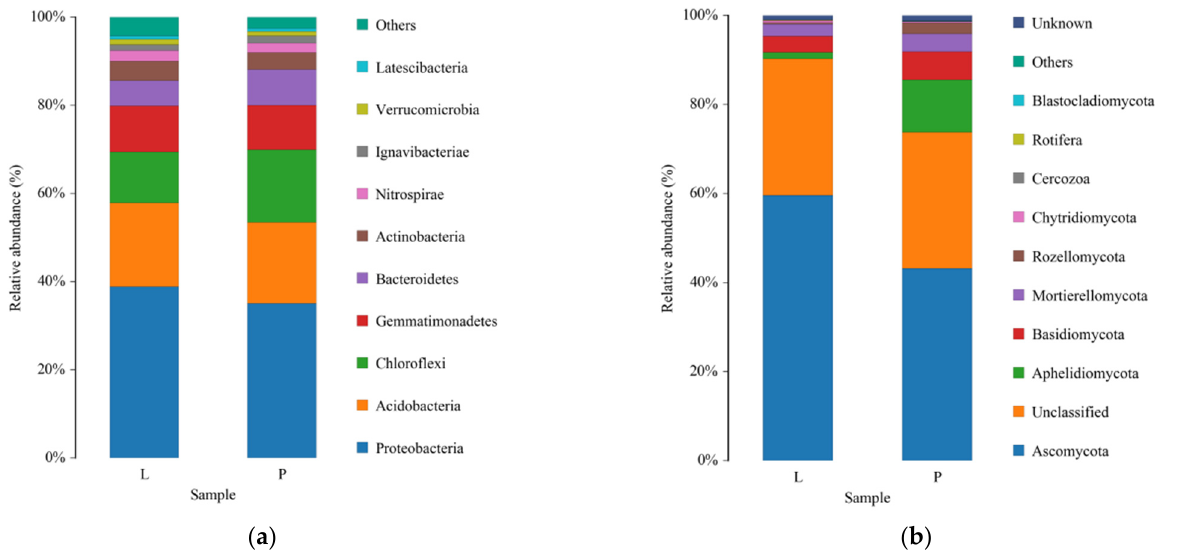
Figure 3. Changes in the relative abundances of ( a ) soil bacteria and ( b ) fungi at the phylum level. L: ridge tillage at two fertilizer depths; P: conventional cultivation.